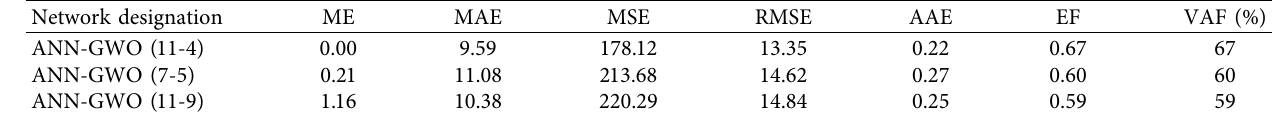
Table 10: Statistics of top 3 seven-input ANN-GWO models on testing